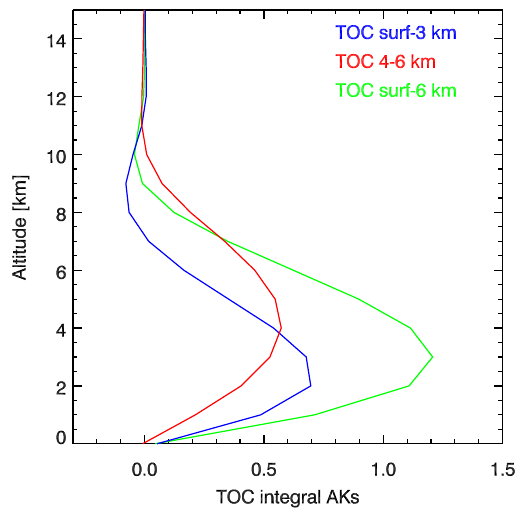
Fig. 3. Mean integral averaging kernel functions for the surface–